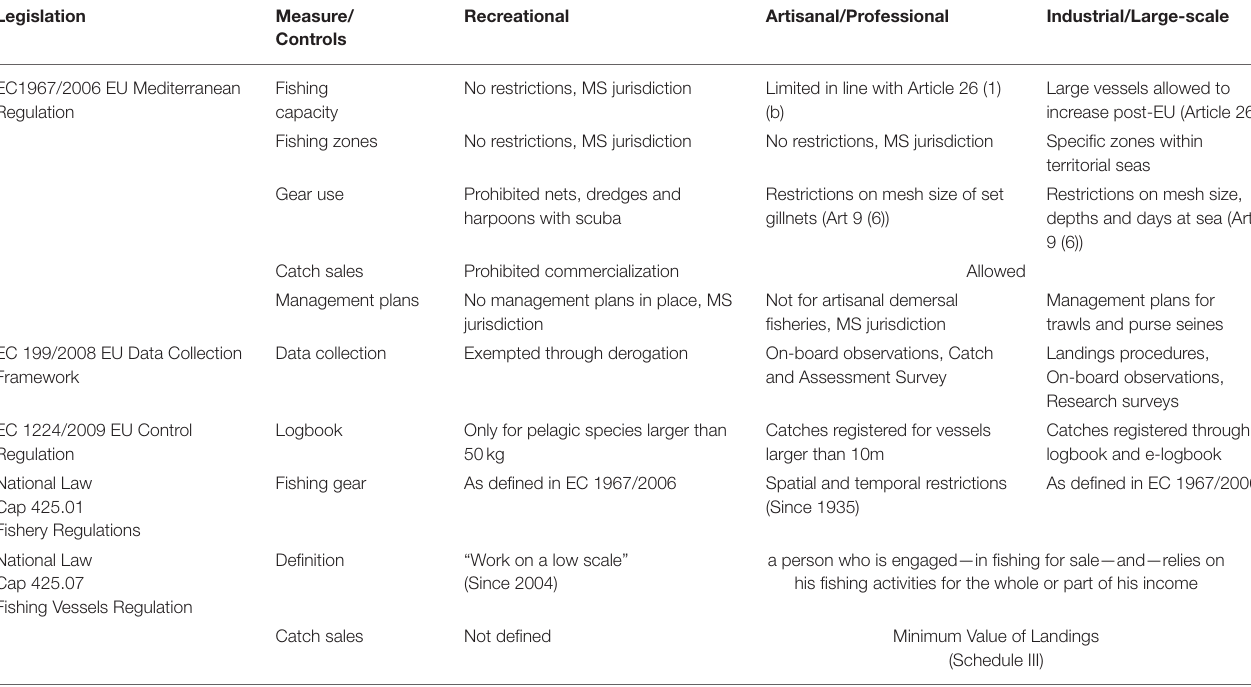
TABLE 1 | European and national regulations regulating industrial, artisanal and recreational fisheries in